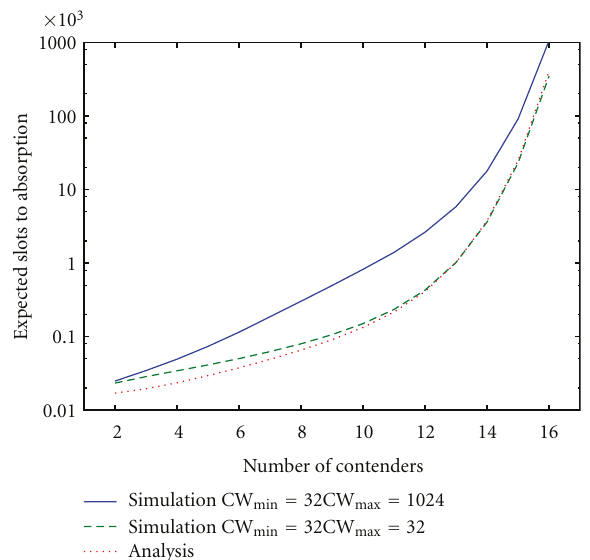
Figure 2: Number of expected slots to reach collision-free opera- tion in